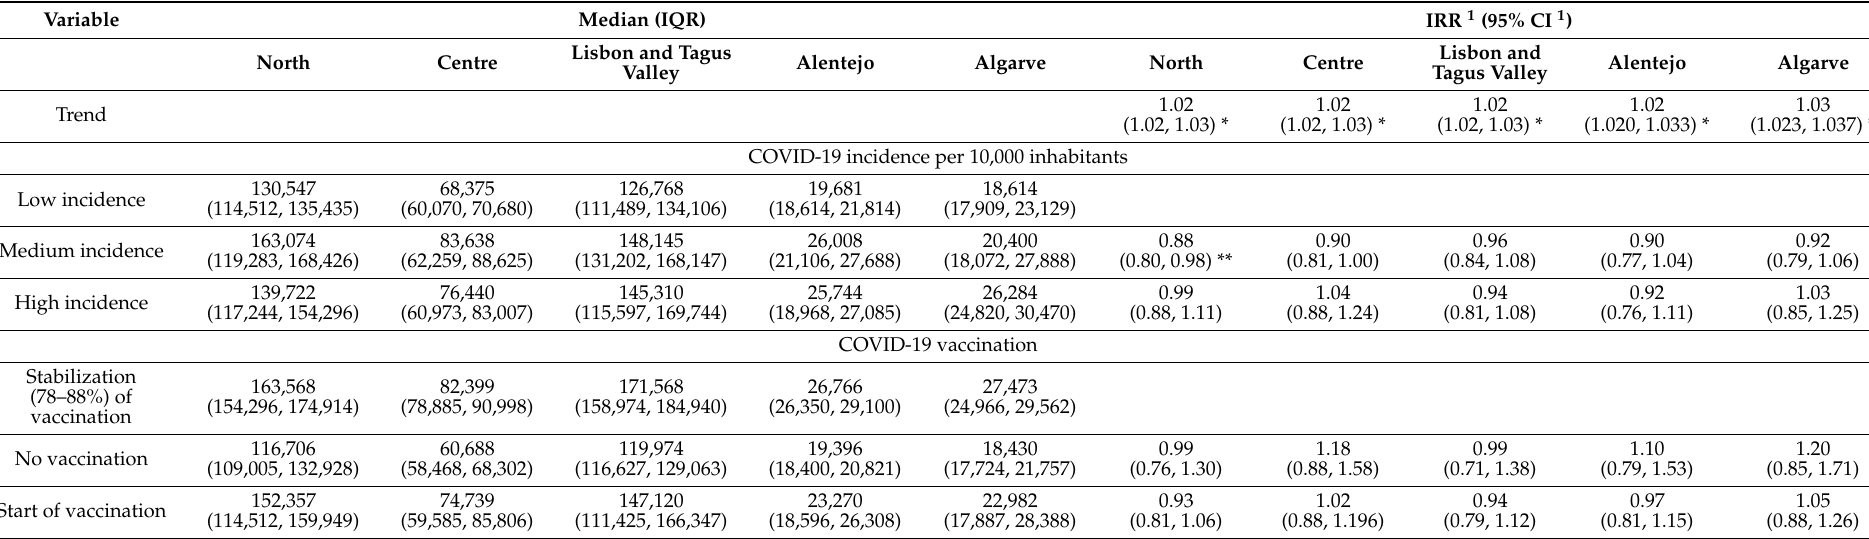
Table 4. ED visits for the variables and regression analysis for ED visits during the pandemic in the five